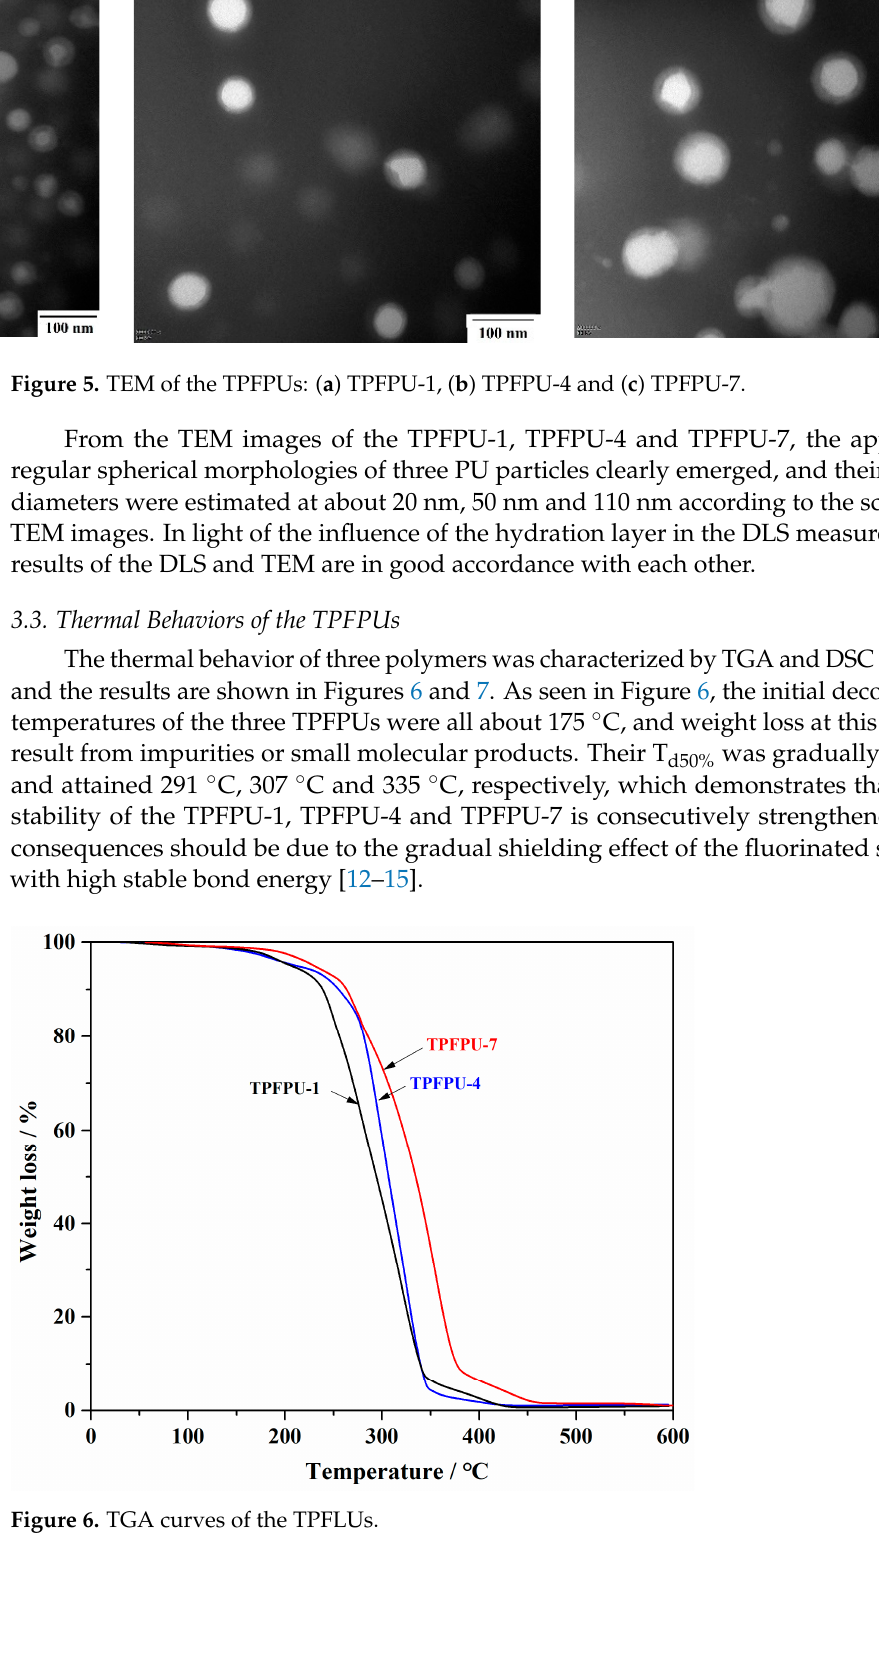
Figure 4. Particle size distribution of the TPFPUs.